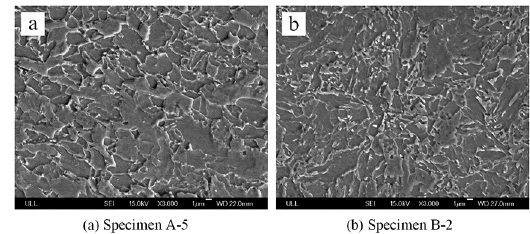
Figure 5. SEM micrographs of specimens after UFC